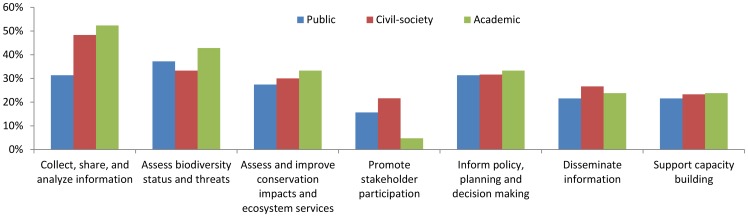
Perceived benefits of using global data within a dashboard approach, by sector.Number of respondent is 51 for public sector, 60 for civil-society, and 21 for academic sector.